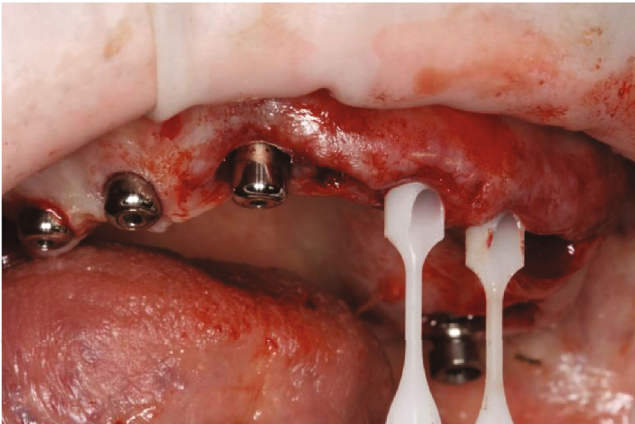
Figure 6: Intraoperative selection of 30 degrees multiunit abutments at the front side of maxilla and installation healing caps at the distal side.